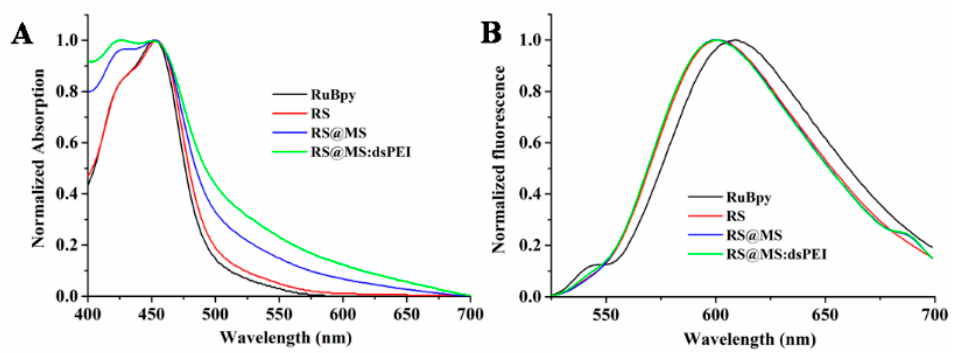
Figure 3. ( A ) Normalized absorption spectra of RuBpy, RS, RS@MS, and RS@MS:dsPEI. ( B ) Normal- ized fluorescence emission spectra of RuBpy, RS, RS@MS, and RS@MS:dsPEI.